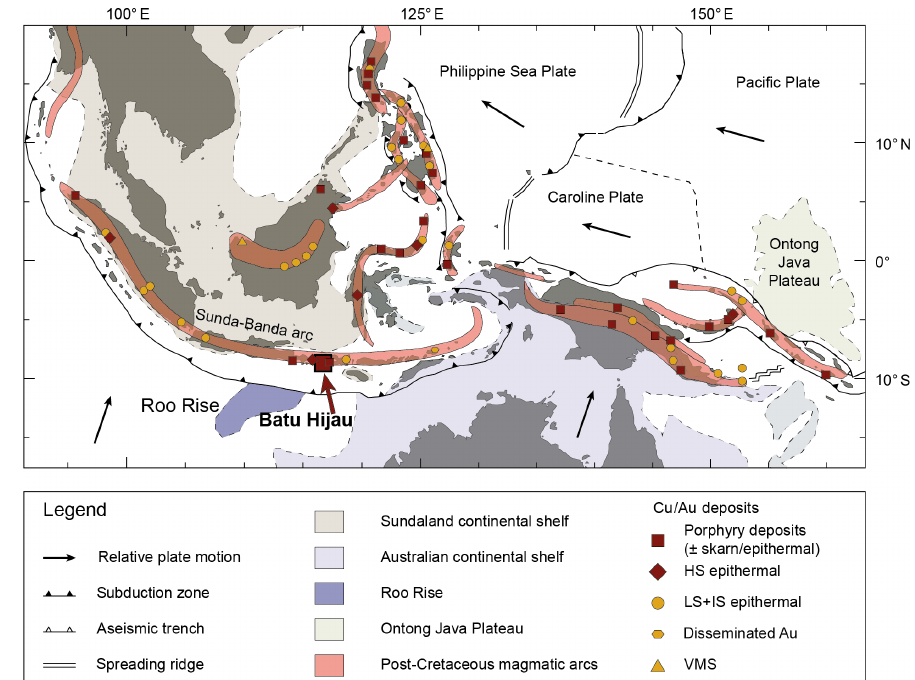
Figure 1. Tectonic map of South East Asia and the south-west Pacific. The Batu Hijau porphyry Cu–Au deposit (enlarged red square) is located on Sumbawa on the subduction-related magmatic Sunda–Banda arc within a small corridor between 110 and 120 ◦ E that hosts several porphyry deposits. Arrows display plate motion relative to the Eurasian plate (Sundaland shield) but do not indicate velocity. HS: high sulfidation; IS: intermediate sulfidation; LS: intermediate sulfidation; VMS: volcanic hosted massive sulfide deposit. Most deposit locations are from Garwin et al.